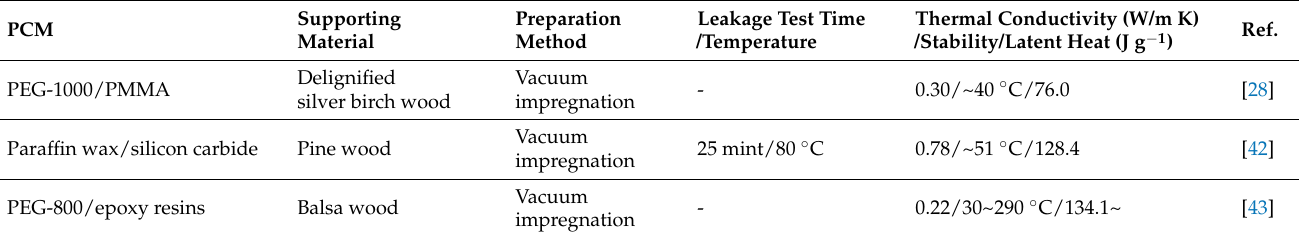
Table 2. Physicochemical parameters of representative PCM materials of this